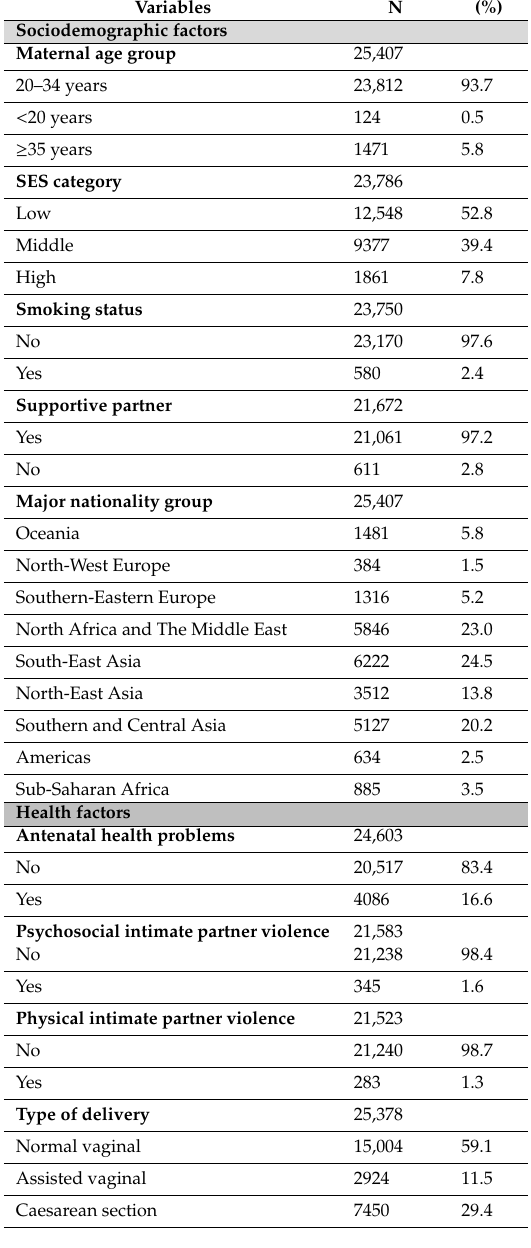
Table 1. Characteristics of the study population ( N =